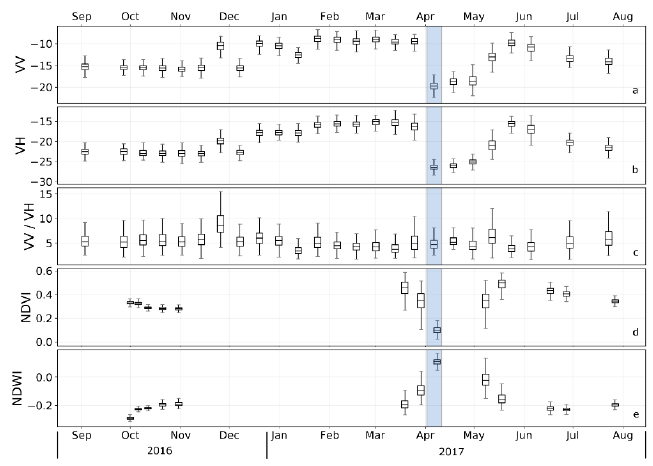
Figure 5. Multi-temporal behaviour of the backscatter intensity for TOW areas for VV ( a ), VH ( b ), the ratio VV/VH ( c ), NDVI values ( d ), and NDWI values ( e ). The blue bars mark the analysed date at the flood event.